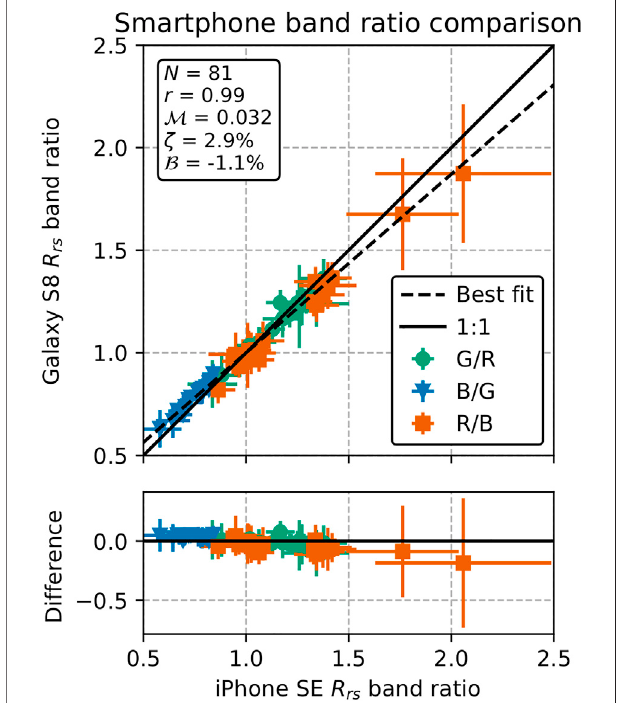
FIGURE 6 | Comparison between iPhone SE and Galaxy S8 R rs measurements inthe RGB bands. The solid linecorresponds toa 1:1 relation, the dashed lineisthebest- fi ttinglinearregressionline.The statistics inthetext box are based on a 1:1 comparison, as are the differences in the lower panel.